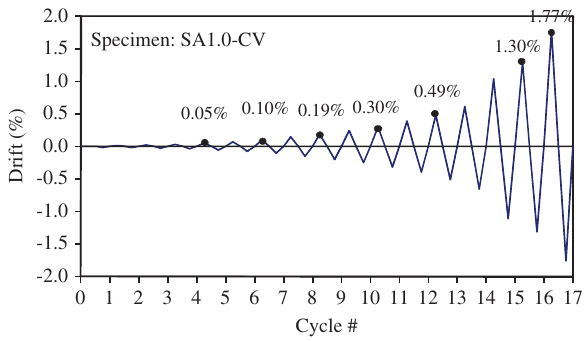
Figure 7 Displacement controlled loading regime for specimen SA1.0-CV.